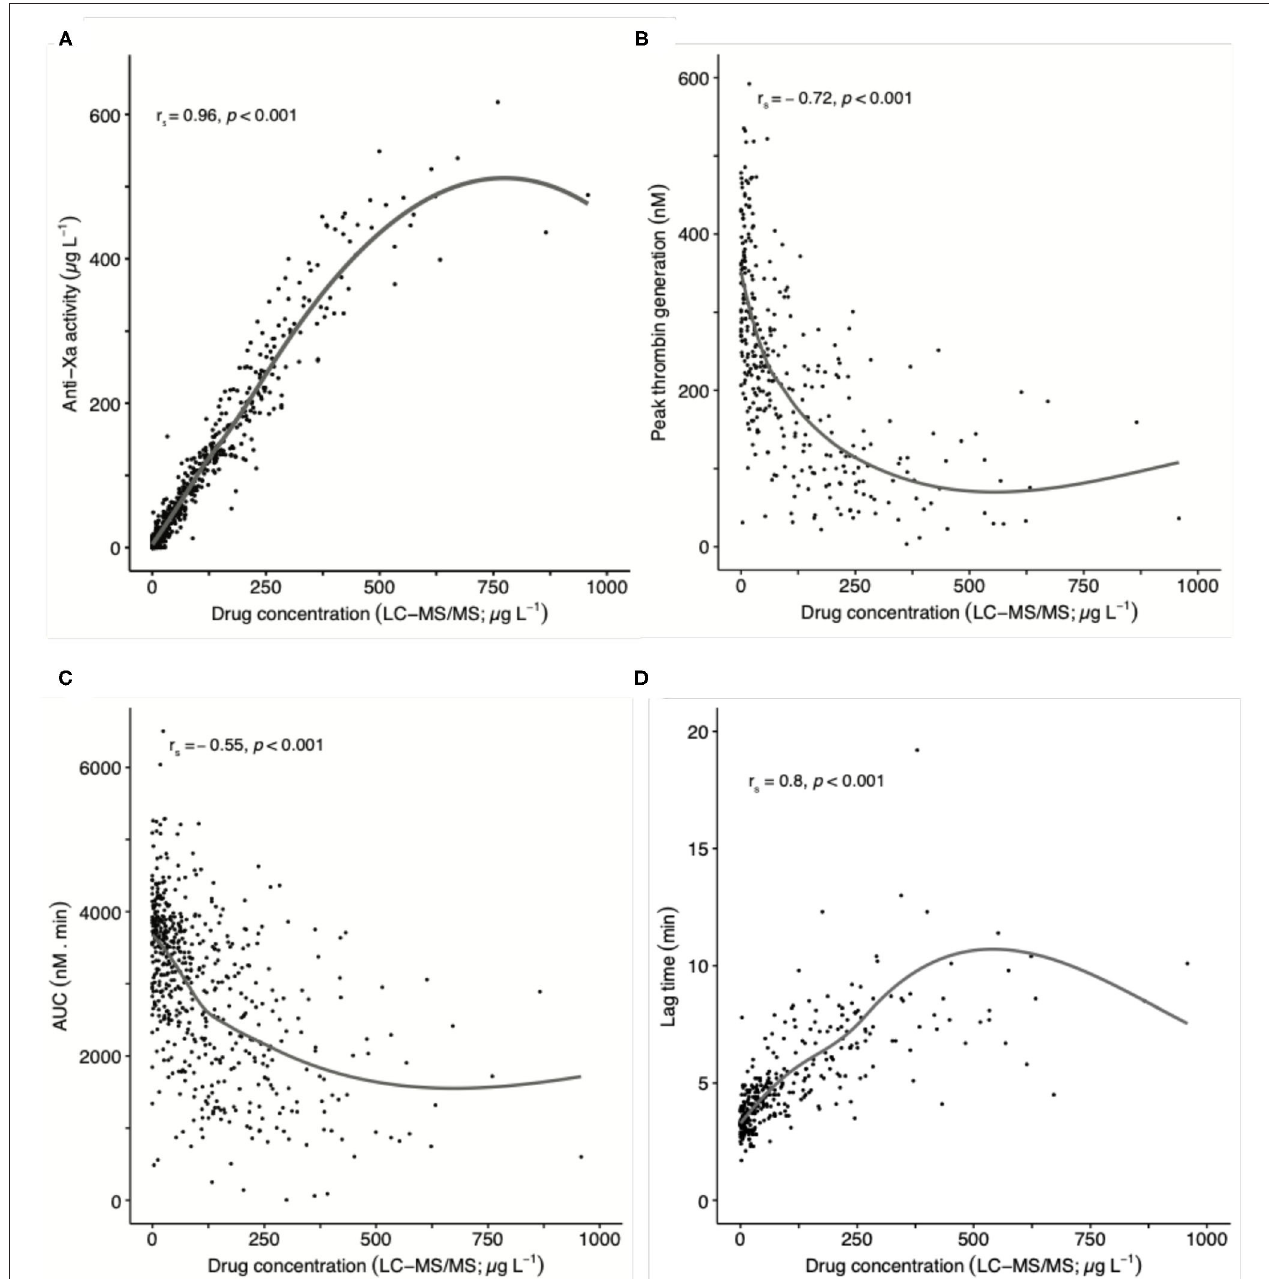
FIGURE 2 | Association of thrombin generation results and anti-Xa measurements with drug concentration in 559 patients taking rivaroxaban, apixaban, or edoxaban in clinical practice (pooled data): (A) anti-Xa activity, (B) peak thrombin generation, (C) area under the curve (AUC), and (D) lag time. Ultra-high performance liquid chromatography-tandem mass spectrometry (LC-MS/MS) was used to determine drug levels. The overall Spearman’s correlation coefficient (r s ) was 0.96 in case of anti-Xa measurements, − 0.72 in case of peak thrombin generation, − 0.55 in case of AUC, and 0.80 in case of lag time. A non-linear (smooth) curve is given to illustrate the